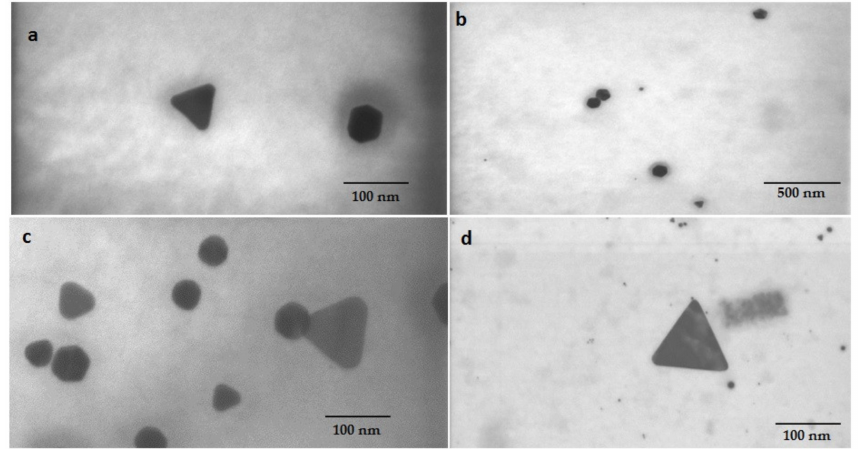
Figure 5. Triangular-, spherical- and hexagonal-shaped GNP synthesized by N. shiloi . TEM images